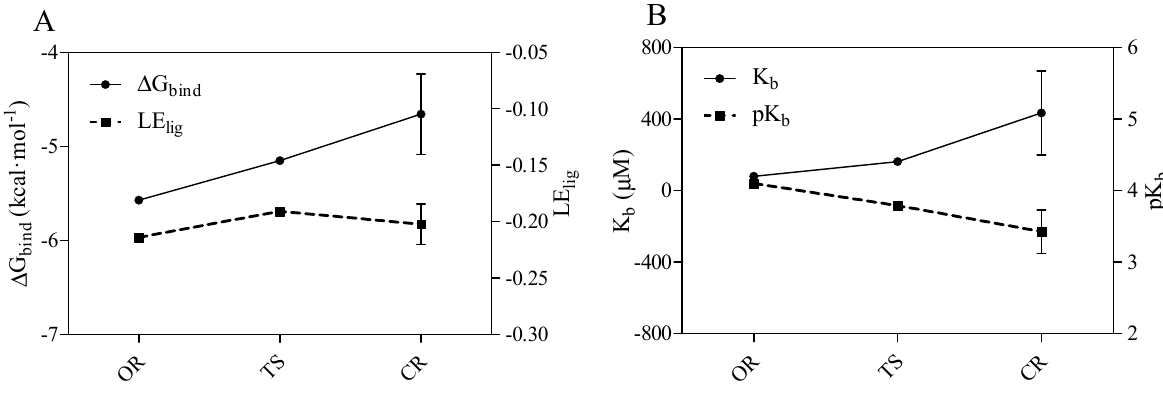
Figure 4. Predicted Gibbs free energy of binding ( (cid:1986)(cid:1833) ( (cid:1838)(cid:1831) ) ( A ) and equilibrium binding constants ( (cid:1837) (cid:3039)(cid:3036)(cid:3034) state intermediate (TS), and closed-ring (CR) ring forms of midazolam complexed with TRIMEB. The ligand efficiency is defined as the calculated (cid:1868)(cid:1837) heavy atoms in the ligand. The data represent means ± S.D. of three independent